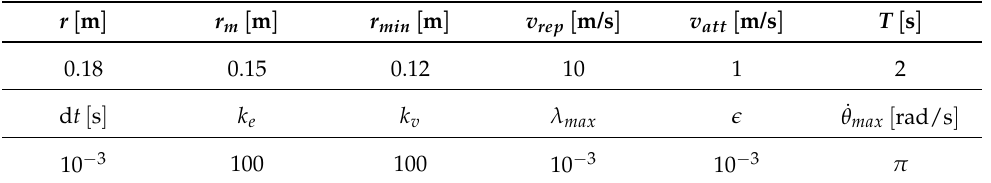
Table 1. Parameters values used for simulations.